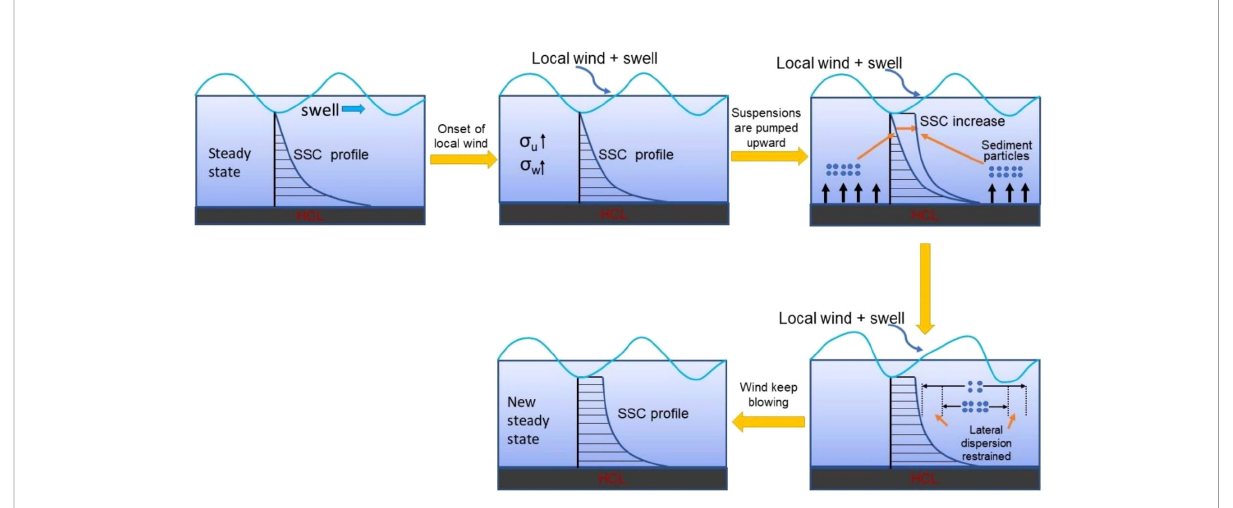
FIGURE 9 The concept diagram on mechanisms of wind effects on SSCs outside the